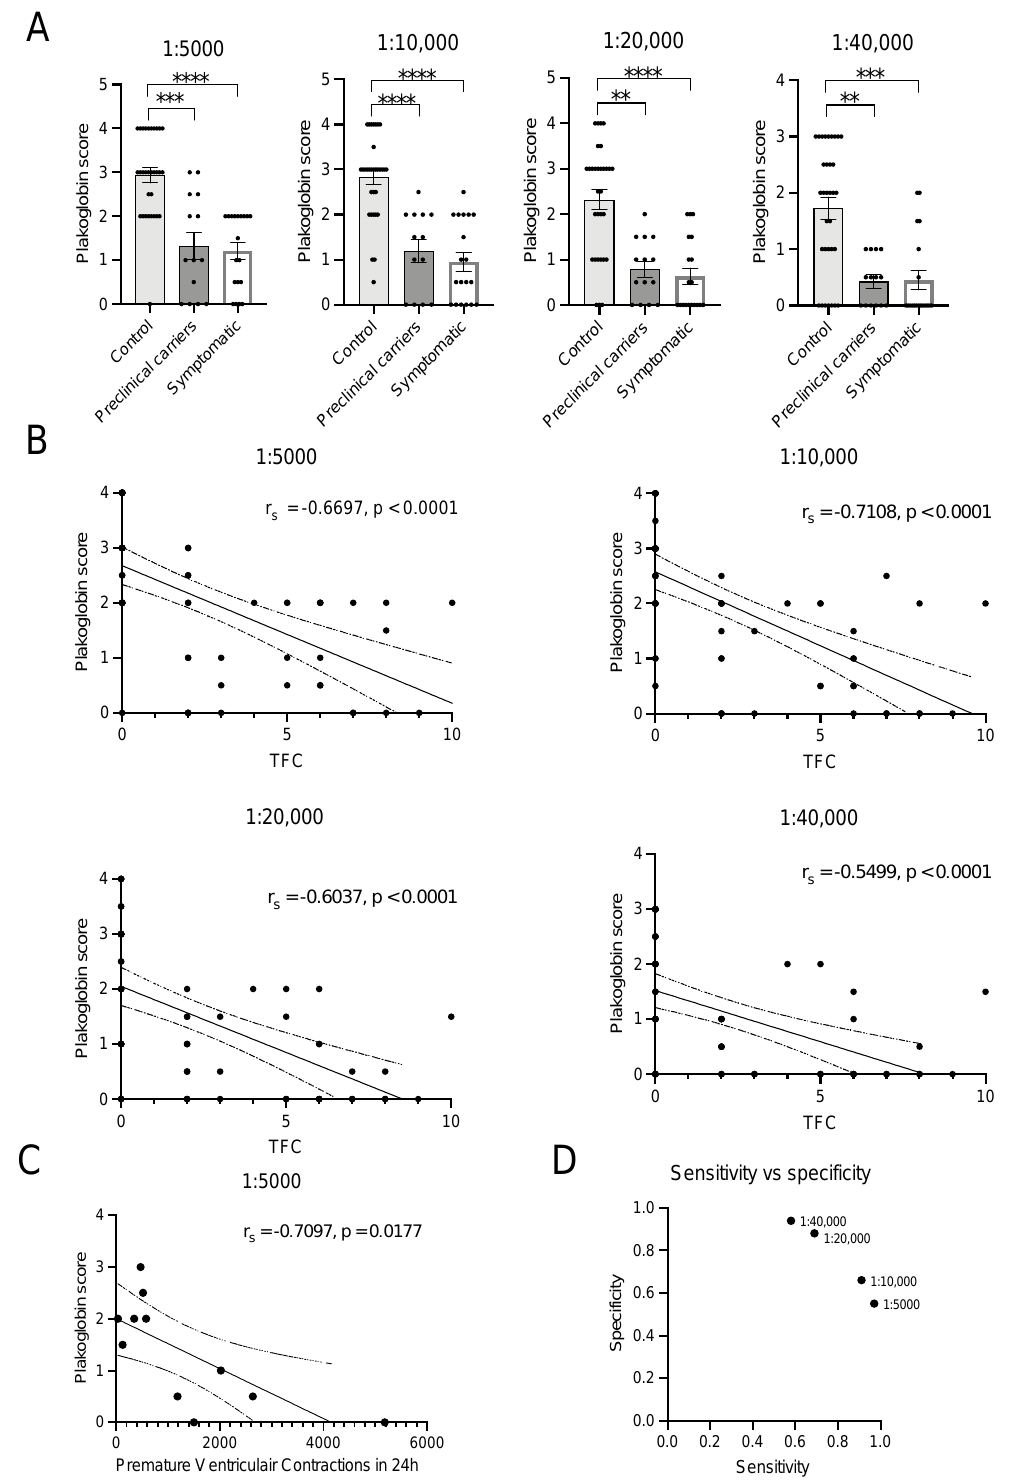
Figure 5. ( A ) Strong and significant differences at the population level between healthy controls ( n = 34), preclinical carriers ( n = 14) and ACM diagnosed patients ( n = 19) in all four dilutions. ( B ) Spearman correlation graphs for plakoglobin score and TFC are shown. ( C ) There is a strong significant correlation with premature ventricular contractions in ACM patients ( n = 11). ( D ) Compar- ison of the sensitivity and specificity score of each dilution used in this study. TFC; Task Force Criteria score 2010, r s ; Spearman’s rho. • indicate individual(s) for the correlation or represent dilution factor in figure D. **** p < 0.0001, *** p < 0.001, ** p <